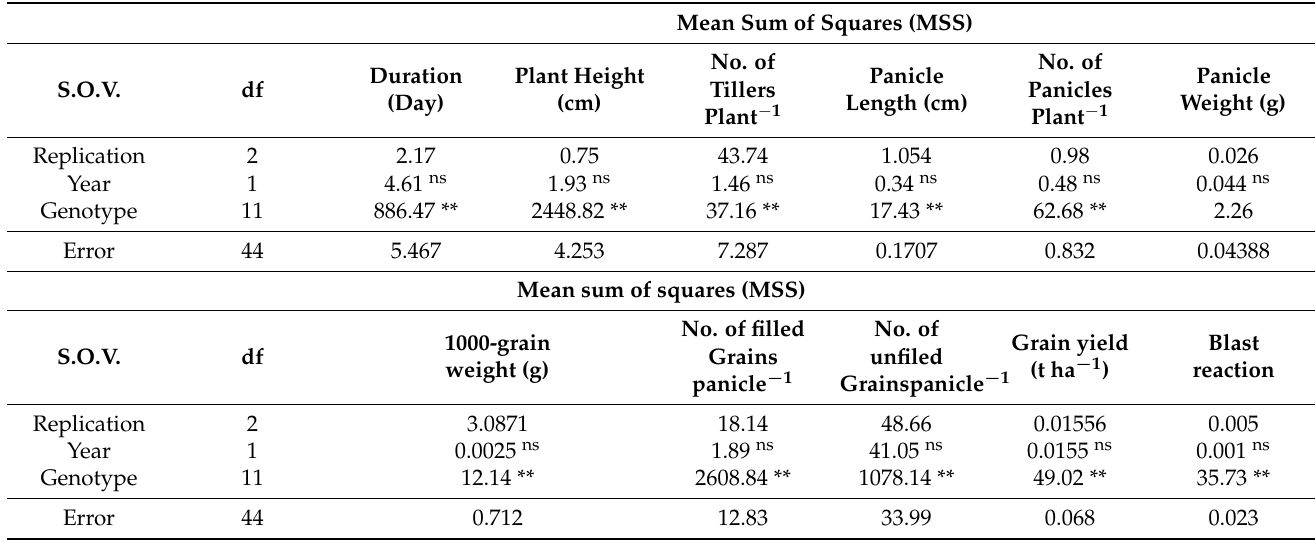
Table 5. Analysis of variance for agro-morphological traits in 2019 and 2020. Mean Sum of Squares (MSS)